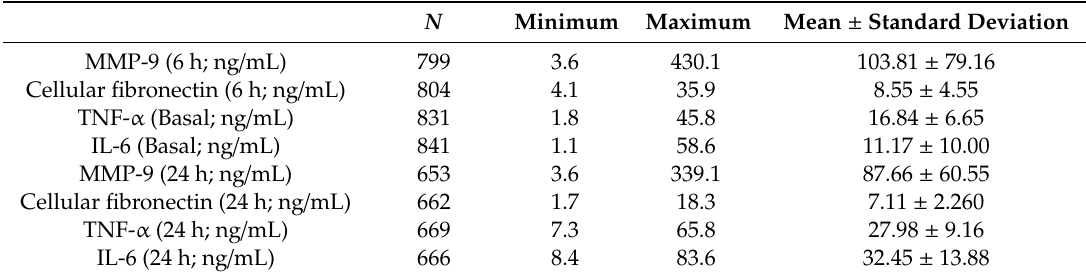
Table 4. Levers of biomarkers analysed at 6 and 24 h.